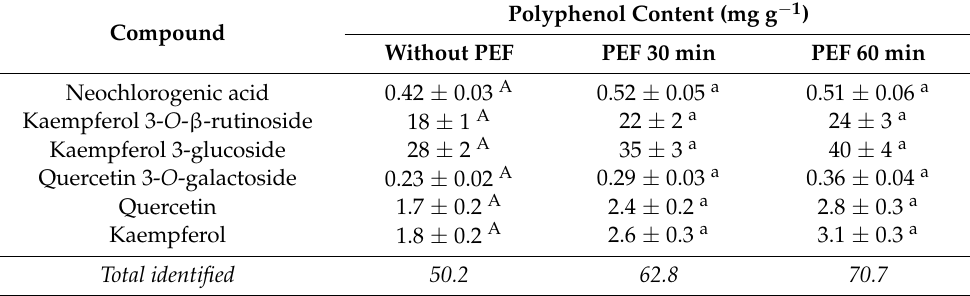
Table 1. Content of specific polyphenols in the extracts (expressed as mean values ± standard deviation of nine replicate analyses) extracted with US only (without PEF) and after pretreatment with PEF for 30 or 60 min; Statistically significant differences are denoted with capital and small letters for p <